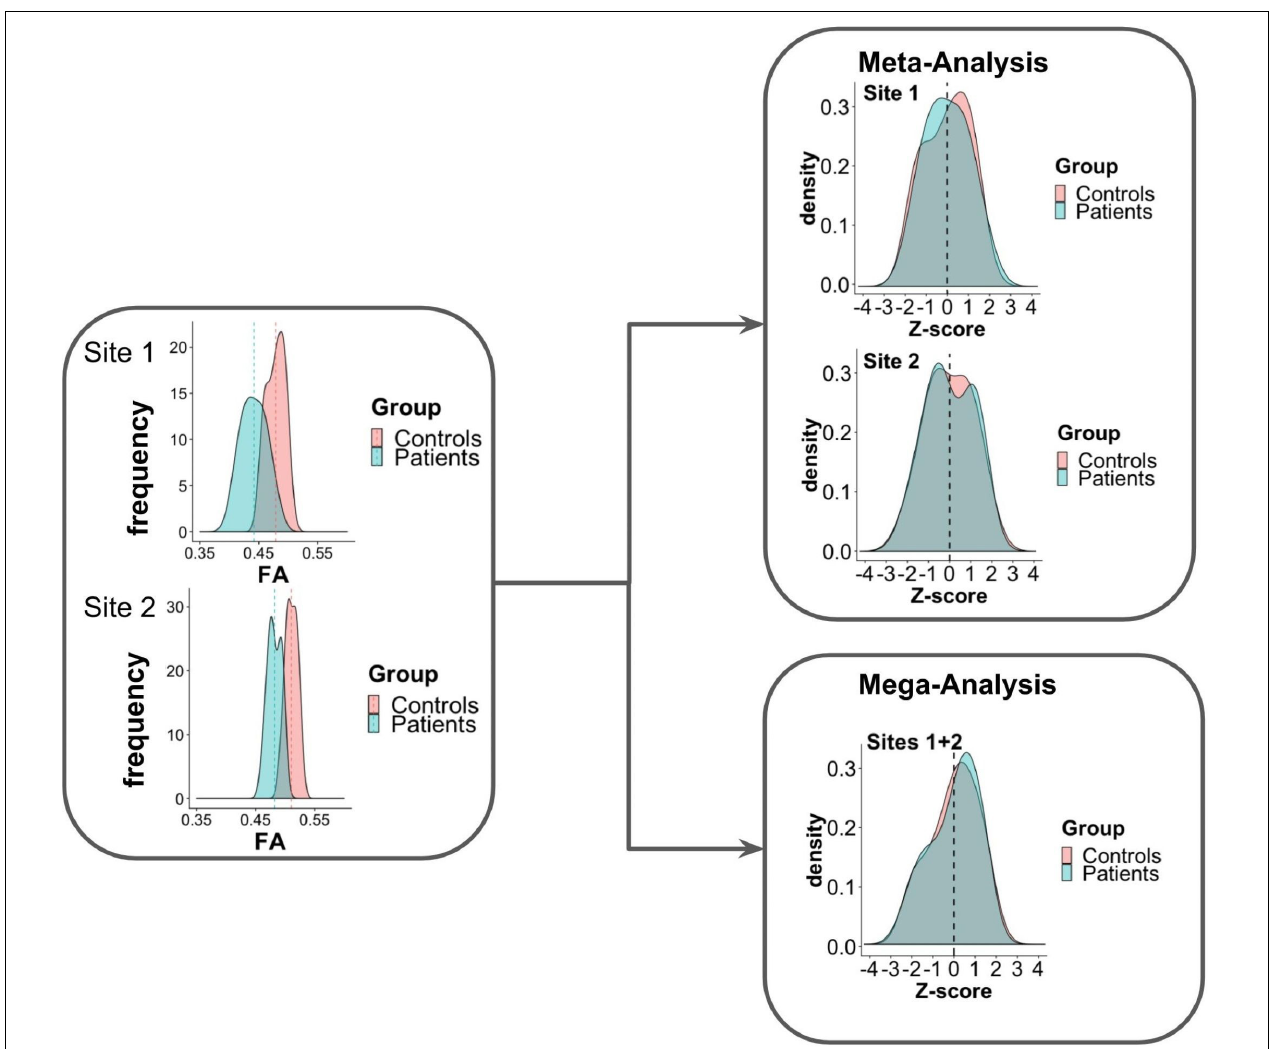
FIGURE 1 | Scheme of meta- and mega-analysis. FA measures from sites 1 and 2, for two groups of subjects: controls and patients. The FA frequency for each group is estimated for each of the sites. Meta-analysis performs the statistical evaluation between groups for each site separately, followed by a weighted combination of its statistical results, while in mega-analysis a weighted statistical evaluation is performed for all sites